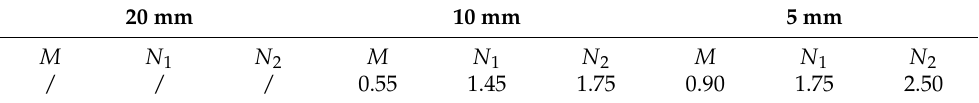
Figure 16. Influenced zones of deep excavation on adjacent tunnel displacement after ground improvement. Table 5. Determination parameters of the scope of influenced zones after ground